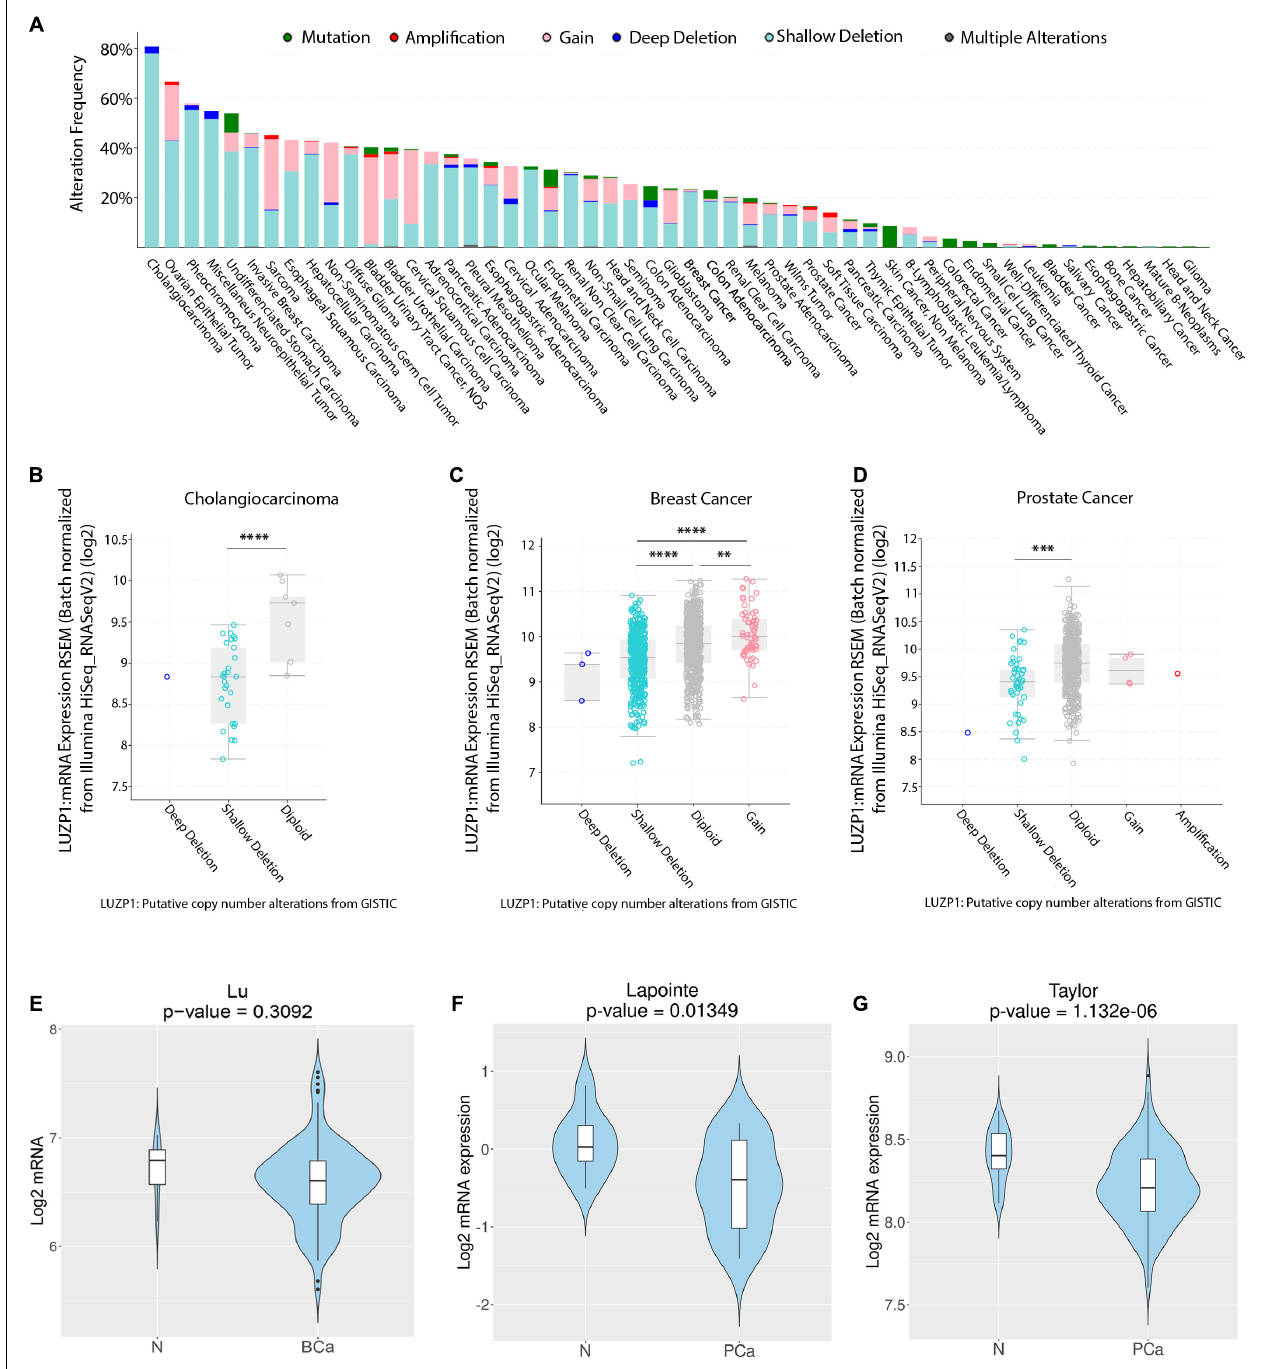
FIGURE 1 | Copy number alterations and aberrant LUZP1 gene expression in cancer. (A) Copy number alterations (CNA) (mutations-green; amplifications-red; gain-light pink; deep deletions-blue; shallow deletions-aquamarine; multiple alterations-gray) in different TCGA tumor types ( n = 10,967). (B–D) LUZP1 mRNA expression (RNAseq) sorted by CNA in (B) Cholangiocarcinoma ( n = 195), (C) Breast ( n = 1,918), and (D) Prostate Cancer samples ( n = 324). When n > 3, data were analyzed by One-way ANOVA or Kruskall-Wallis and the corresponding post hoc test. (E) Violin plots depicting the expression of LUZP1 between non-tumoral (N) and breast cancer specimens (BCa) in the Lu dataset (Lu et al., 2008). (F,G) Violin plots depicting the expression of LUZP1 between non-tumoral (N) and prostate cancer specimens (PCa) in Lapointe et al. (2004) (F) and Taylor et al. (2010) (G) datasets. The Y-axis represents the Log2-normalized gene expression (fluorescence intensity values for microarray data or sequencing read values obtained after gene quantification with RSEM and normalization using Upper Quartile in case of RNAseq). Student T -test was performed in order to compare the mean gene expression between two groups. ∗∗ P < 0.01; ∗∗∗ P < 0.001; ∗∗∗∗ P < 0.0001.